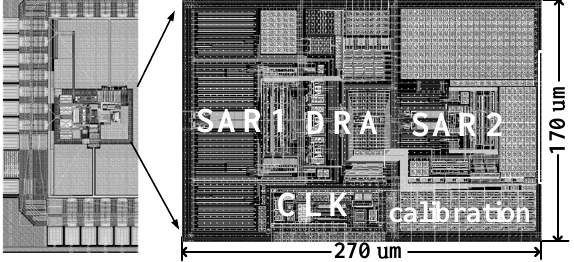
Figure 9. Layout of the proposed ADC.